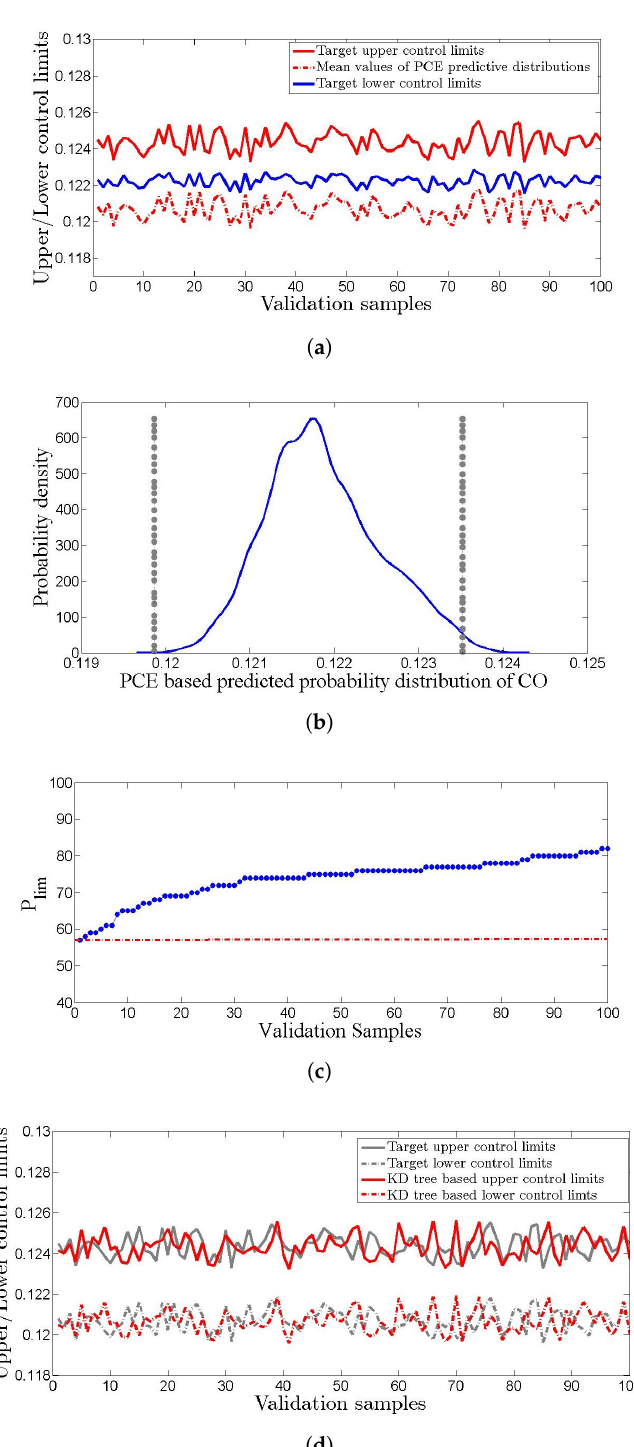
Figure 9. ( a ) Measured data-based control limits and deterministic prediction of the PCE-based method, ( b ) off-line control limits and predictive distribution of CO mass fraction, ( c ) P lim of validation samples, ( d ) measured data-based and k - d tree-based control